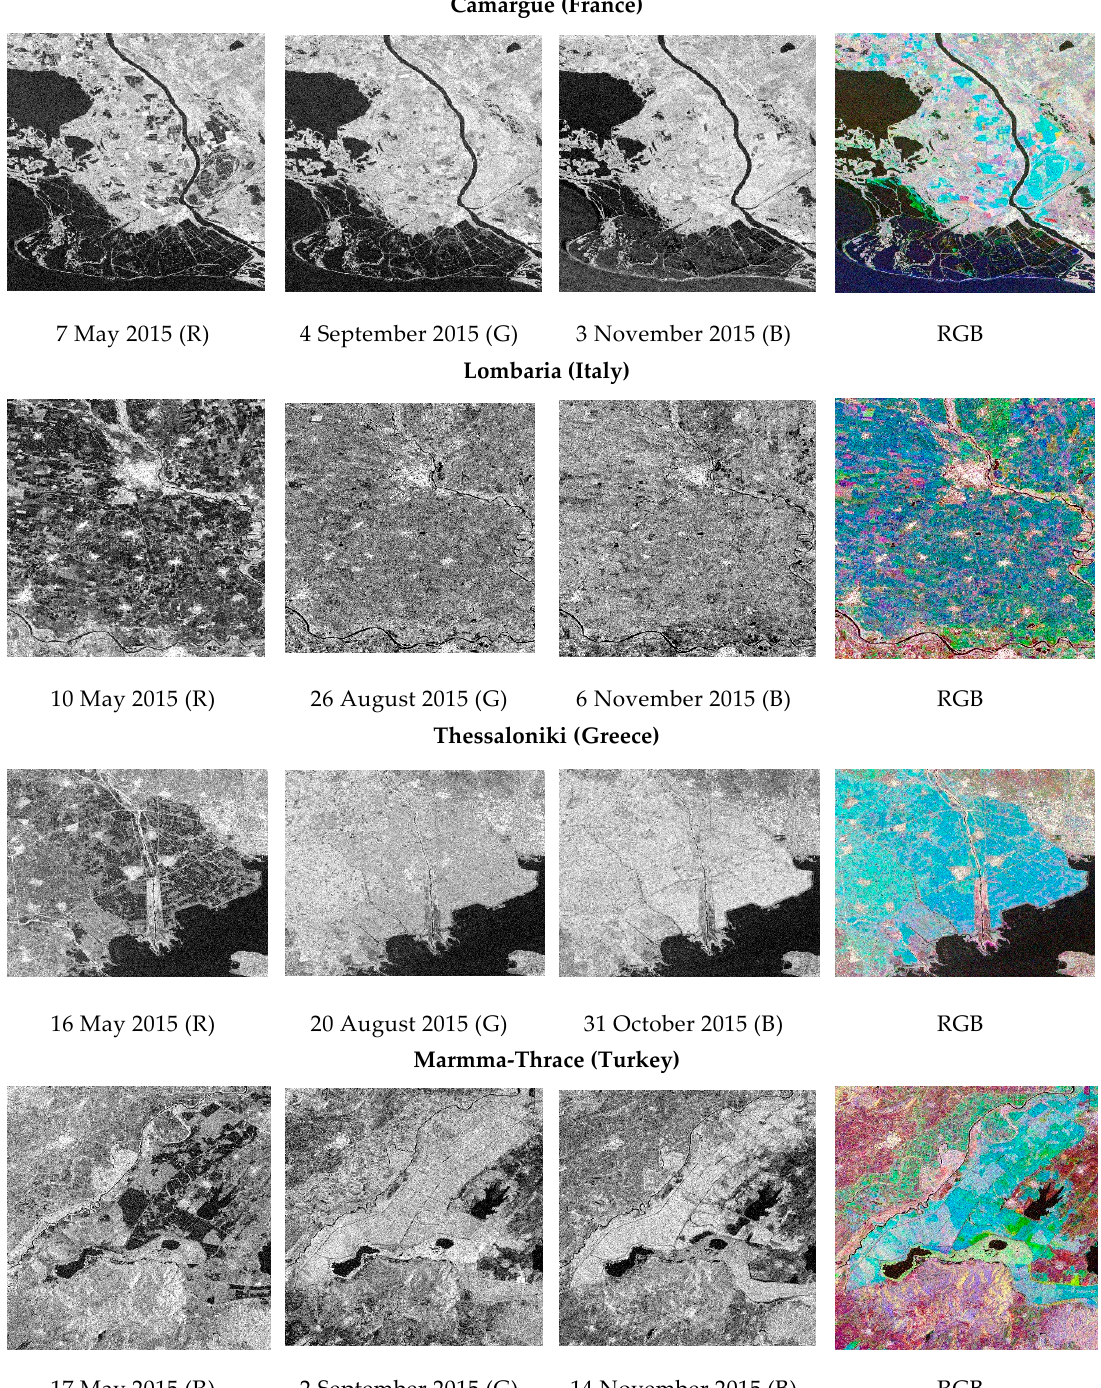
Figure 9. Columns 1–3: images of σ o acquired at three dates (from left to right) and; Column 4: VH images of false color composite over the part of study sites.